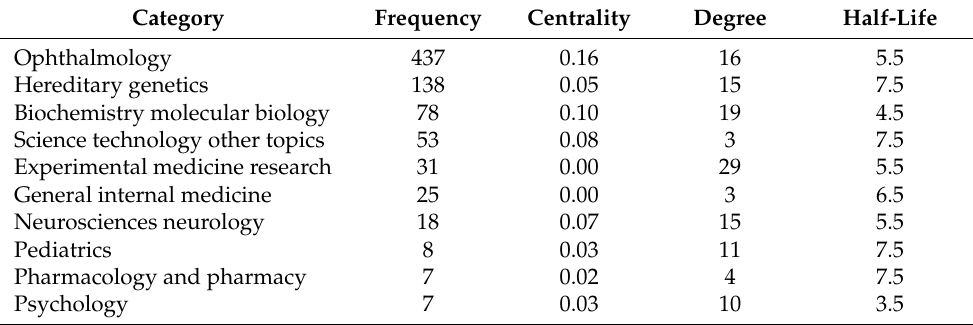
Table 2. The 10 research fields with the highest number of publications.